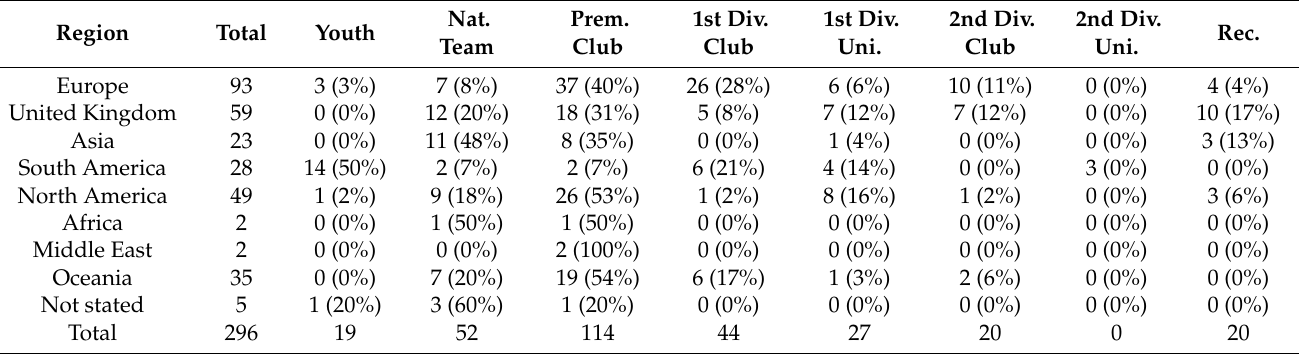
Table 2. Summary of the highest coaching level and geographic region for participants of the coach survey ( n = 296) and the percentage of participants coaching at each level from each region (by row). Nat.